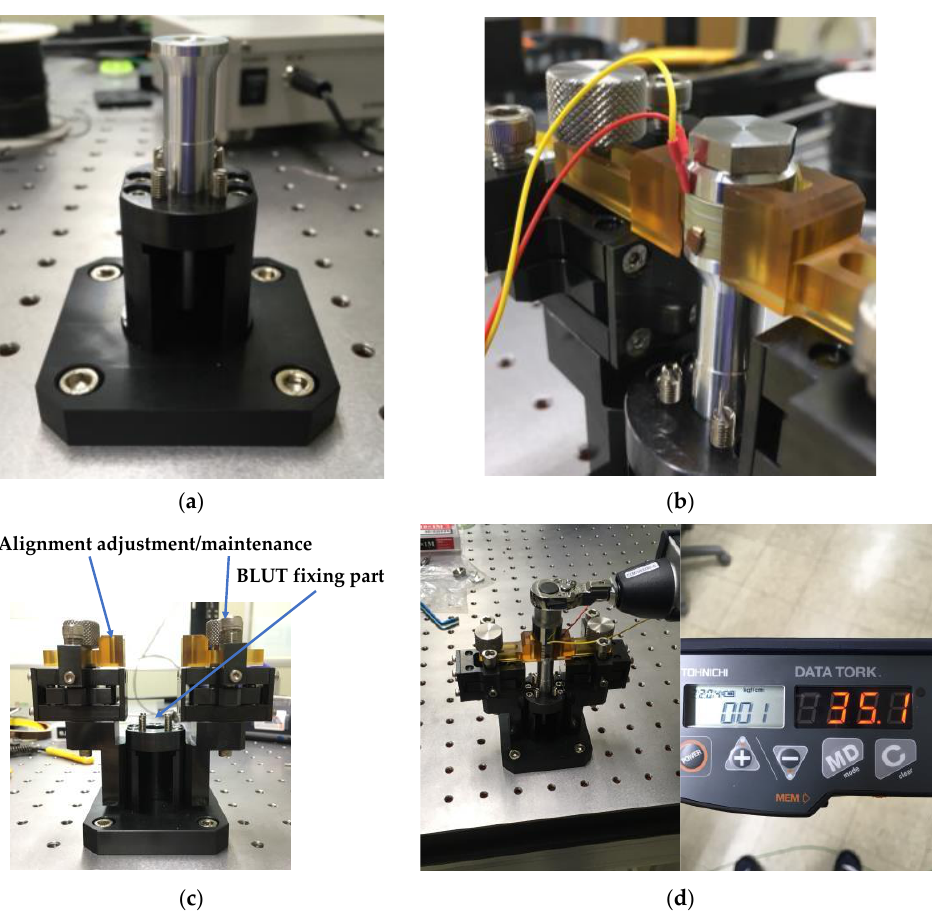
Figure 9. ( a ) Front mass fixing and ( b ) alignment adjustment/maintenance parts; ( c ) assembly jig station; ( d ) manufactured parts for BLUT with digital torque wrench.